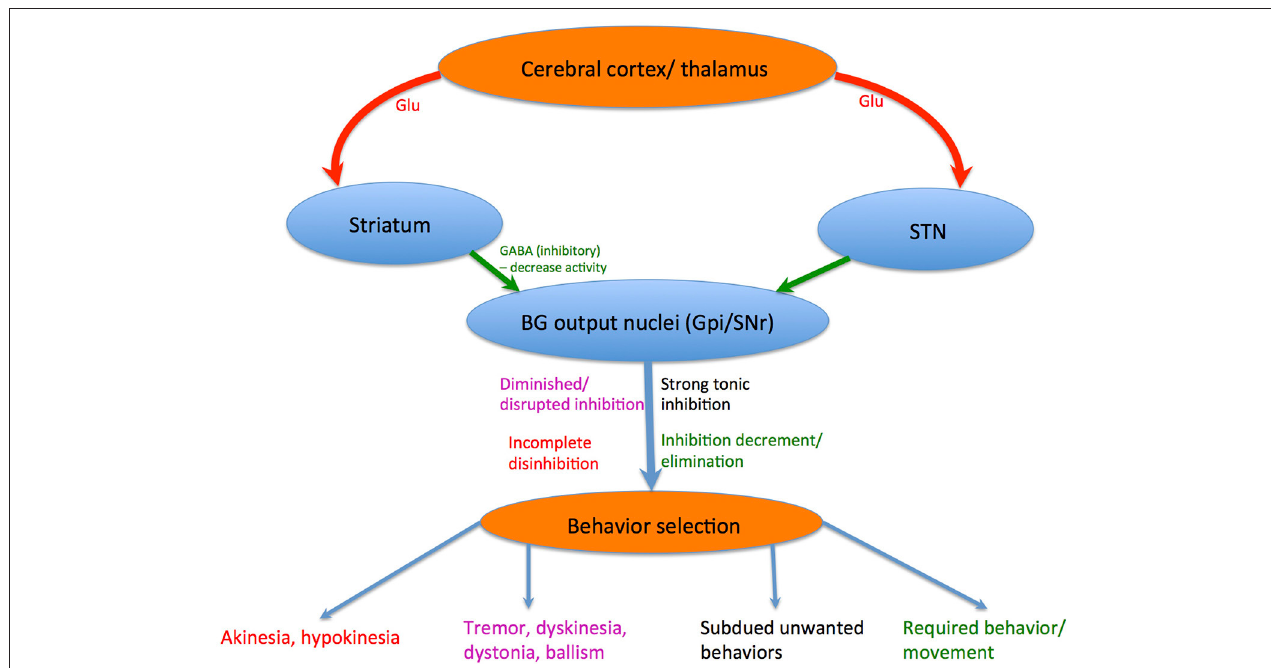
FIGURE 2 | Behavior selection: Red lines depict glutamatergic pathways, whereas green lines depict GABAergic pathways. Blue lines depict chemically composite pathways. The corresponding colored notations show how each different movement disorder is elicited.